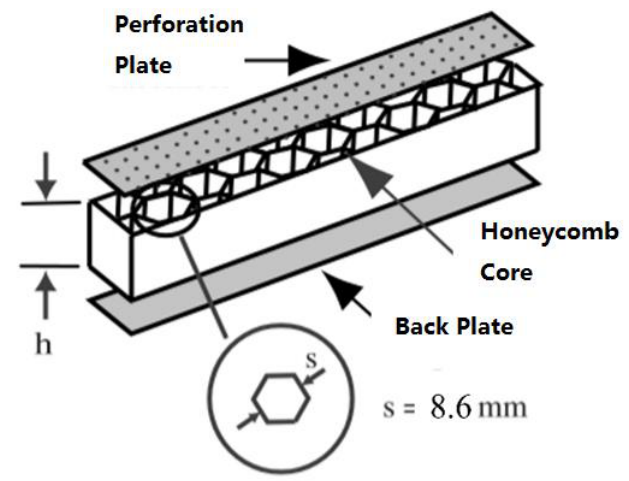
Figure 5. Schematic of tested SDOF liner. Considering the cut-off frequency of the duct, the test frequency ranges from 100 to 4400 Hz, and the step interval is 100 Hz. The incident sound waves are excited by the loudspeaker array. The incident sound pressure level is above 130 dB. The microphone closest to the loudspeaker array is used as the reference. As shown in Figure 6, the red line represents the result measured with the in-situ method (where the left-pointing triangle represents the acoustic resistance, and the down- pointing triangle represents the acoustic reactance). The black line represents the result measured with the straight forward method (where the right-pointing triangle represents the acoustic resistance, and the solid circle represents the acoustic reactance). The two sets of measured results generally agreed with each other in a wide frequency range, except for some obvious differences in the low frequency and high frequency